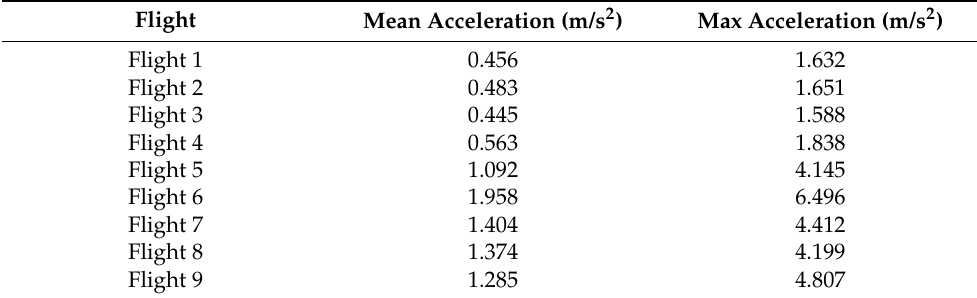
Table 4. Measured horizontal acceleration on the centre of the